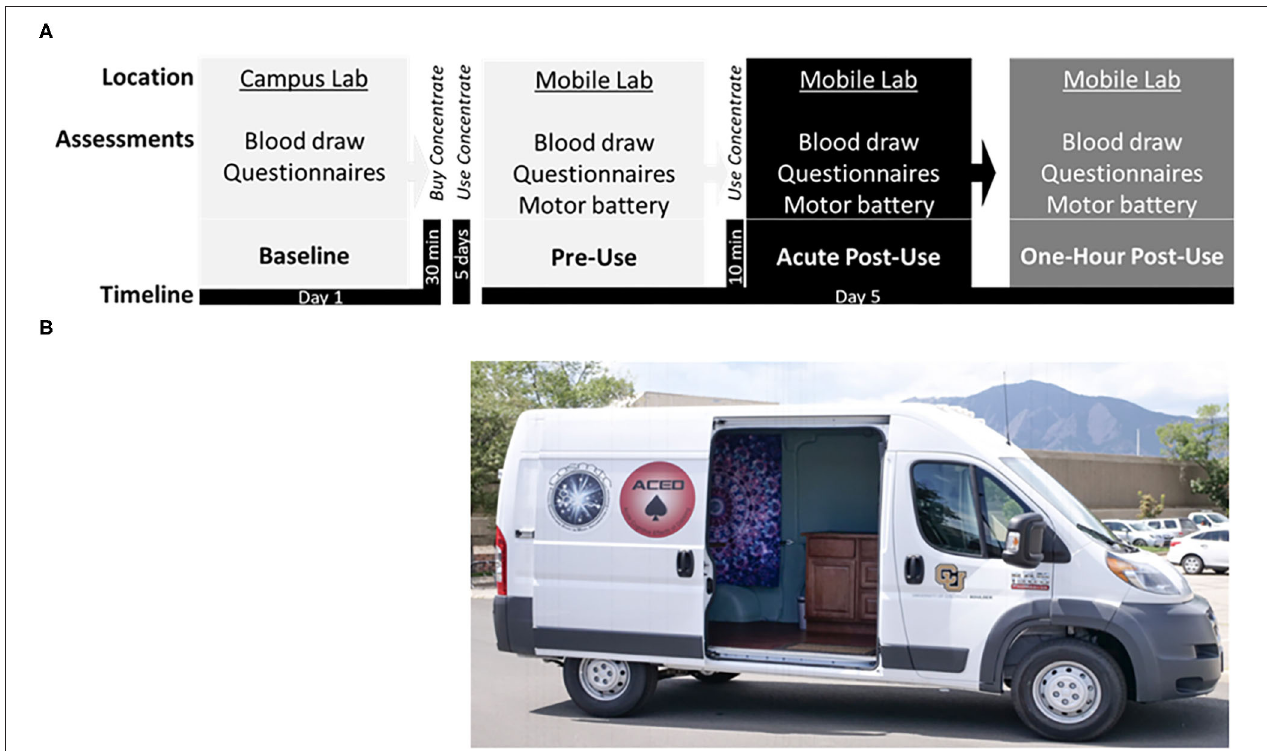
FIGURE 1 | (A) Study timeline displaying the: Baseline session at the campus lab, followed by purchase of cannabis concentrate (70 or 90% THC) at a local dispensary, ∼ 5 days of ad libitum use, and the subsequent Experimental session in the mobile lab, including the pre-concentrate use (Pre-Use) timepoint followed by in-home participant ad libitum use of concentrate, and two post-concentrate use timepoints (Acute Post-Use and 1h Post-Use). (B) Photograph of the Mobile Lab, a high-top cargo van retrofitted with a Wi-Fi hotspot, hand rail and stair step, ice cooler, electrical outlets, a reclining phlebotomy chair, sterile equipment, and a chair/table for motor